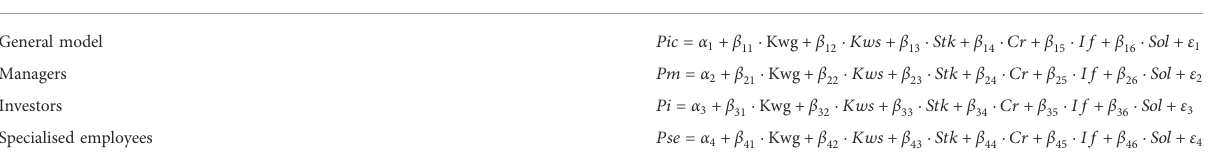
TABLE 3 Dependent variables and regression model equations. Dependent